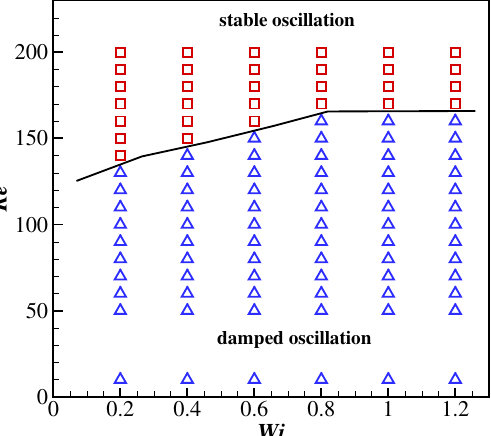
Figure 14. The phase diagram of a filament motion as a function of the Reynolds number and Weissenberg number. (cid:3) , stable oscillations; ∆ damped